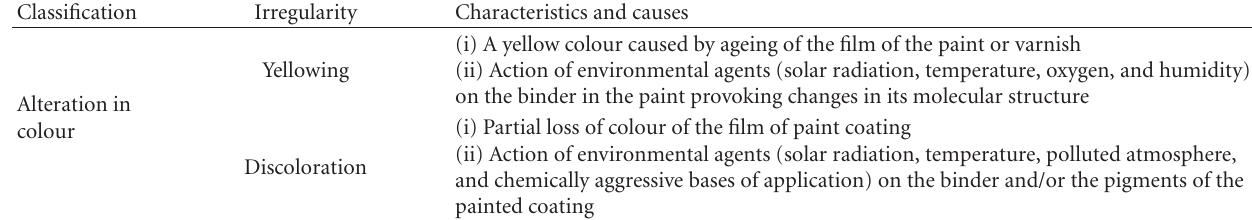
Table 2: Irregularities and causes.